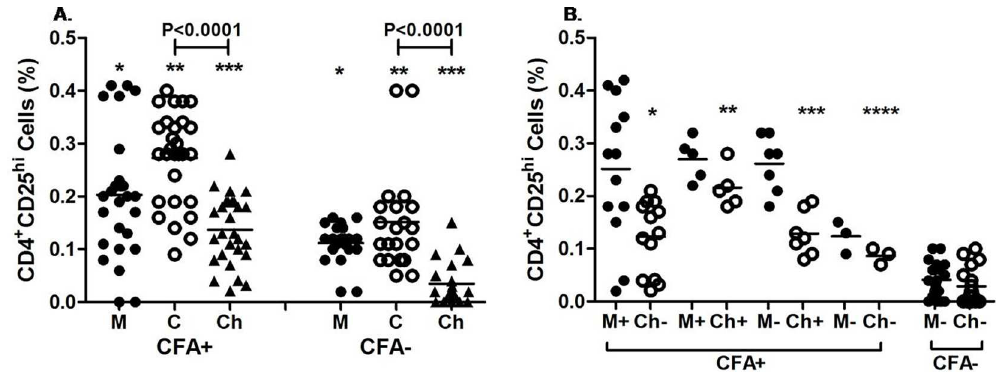
Fig 3. Expression profile of Tregs (CD4+CD25 hi ) cells in mother and cord at the time of enrollment and in children during follow-up. Each dot represents an individual’s frequency of Tregs and lines represent the mean values. A . Treg frequencyof CFA+ve (n = 28) and CFA-ve (n = 21) mother (M) and their cord (C) at the time of deliveryand in children(Ch) duringfollow up. CFA +: mothers CFA +ve at the time of enrolment. CFA-: Mothers who were CFA-ve at the time of enrolment. * p = 0.016, ** p < 0.001, *** p < 0.0001 B . Treg frequency of CFA+ve and CFA-ve mother and their children(Ch) at the time of follow up. M+Ch+: mother and childrenCFA+ve (n = 5), M+Ch- : mother CFA+ and childrenCFA-ve (n = 13), M-Ch+: mother CFA-ve and childrenCFA+ve (n = 7), M-Ch-: mother and childrenare CFA-ve (n = 3). M-Ch-: born from uninfected(CFA–ve) mother (n = 20). * p < 0.0001, ** p =